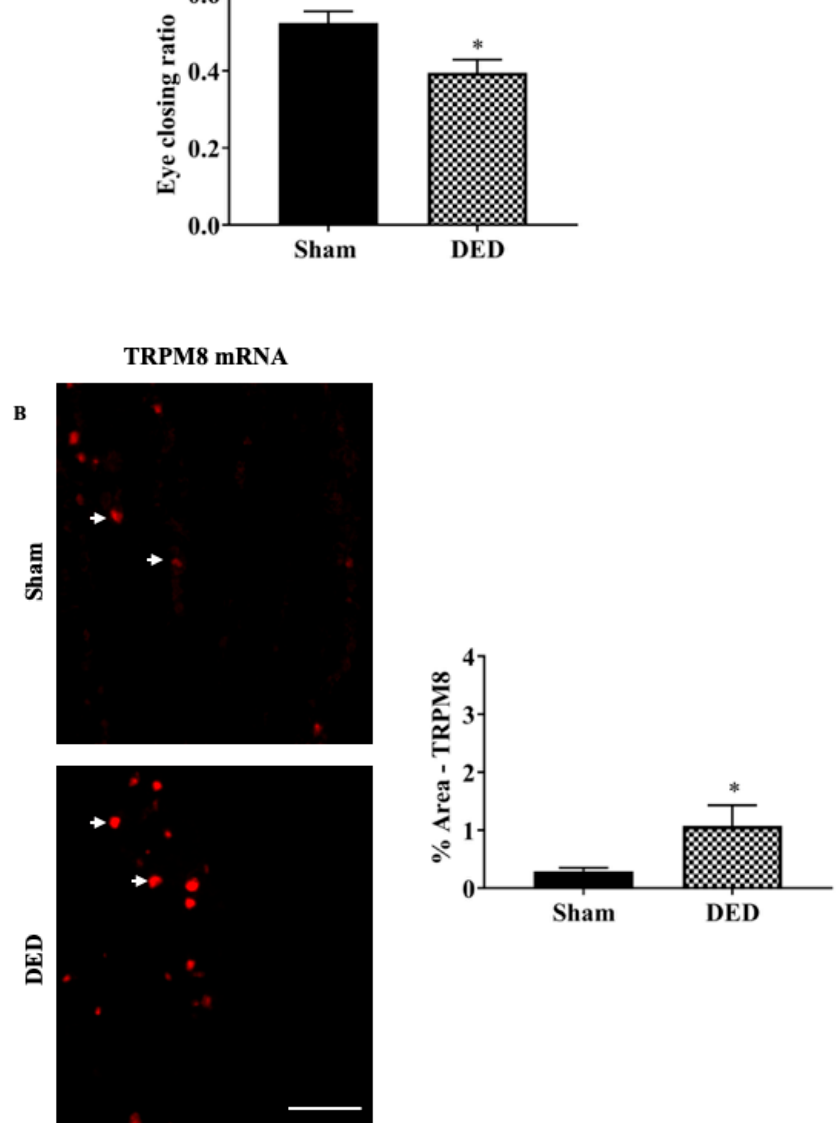
Figure 2. Evaluation of corneal cold sensitivity and TRPM8 expression in the ophthalmic branch of the TGs of sham and DED mice at day 21. ( A ) The cold corneal sensitivity was evaluated using a drop of menthol and recording the eye closing ratio after 5 min (min). ( B ) Staining (white arrows) and quantification of mRNA levels using in situ hybridization of TRPM8 (Opal 650) in the ophthalmic branch of TGs of sham and DED mice. All experiments were conducted at day 21. Sham and DED mice n = 4–5. Scale bar = 50 µ M. * p < 0.05 relative to sham group. Results are expressed as mean ± standard error of the mean (SEM). For statistical analysis, the Kolmogorov–Smirnov test was performed followed by a nonparametric Mann–Whitney using GraphPad Prism version 7.00 (GraphPad Software, La Jolla, CA, USA).